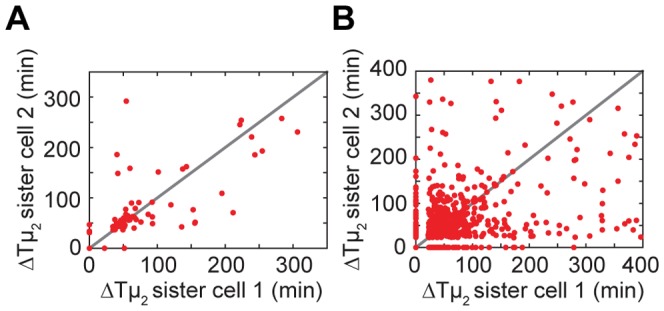
Switching synchrony of sister cells.The growth recovery delays ΔTµ2 are plotted for pairs of sister cells. (A) Data obtained from experiments. N = 75, r2 = 0.52, p-value <0.001. (B) Data resulting from simulations. N = 660, r2≈0.13 and p<0.001. Note that in both cases lineages in which one cell switches but its sister or its progeny does not are not plotted (in total: 22 pairs for the experimental data, 146 pairs for the numerical data).